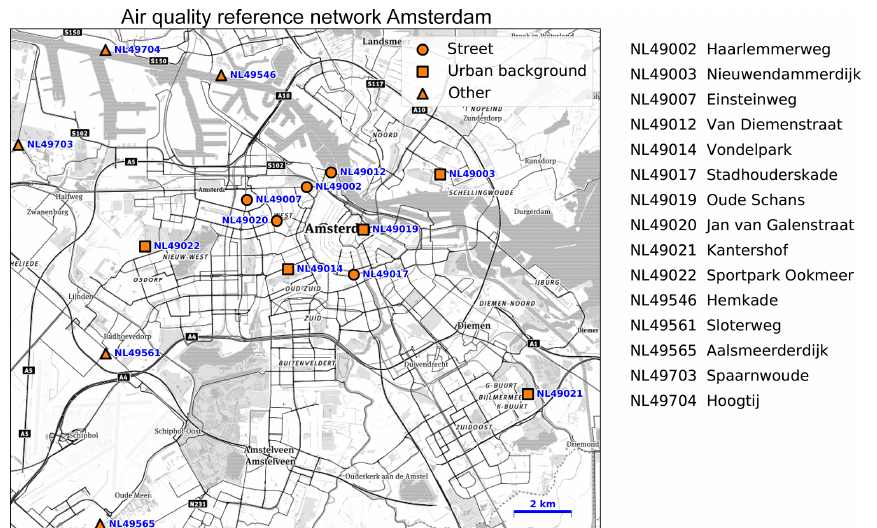
Figure 1. Air quality reference network of Amsterdam. (Basemap source: © Mapbox © OpenStreetMap contributors 2019. Distributed under a Creative Commons BY-SA License.) Table 1. Overview of AERMOD simulation settings. Road width 20m